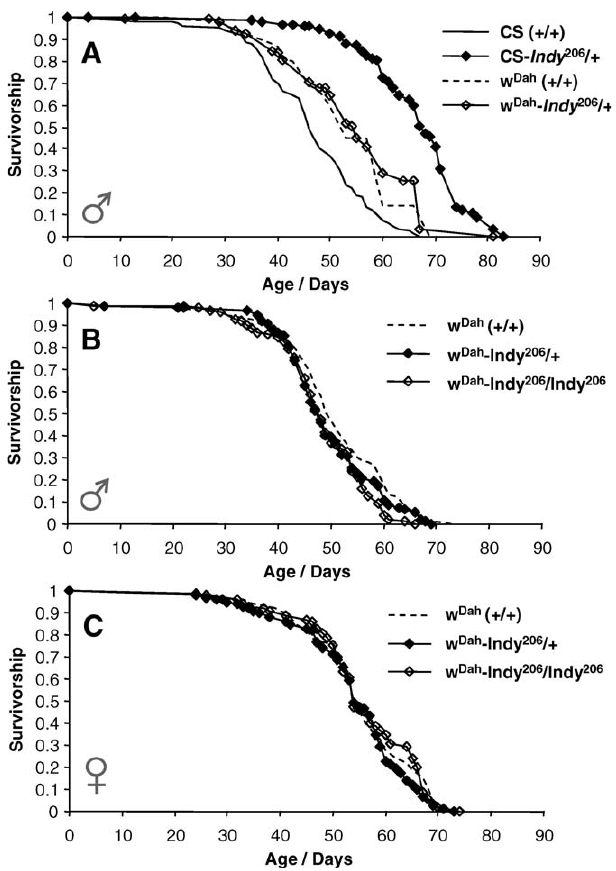
Figure 4. SuccessiveBackcrossingAbolishes Indy 206 -AssociatedLongevity A) Survival of the original versus w Dah -backcrossed ( 3 8) males on SY food. The data are male progeny derived from crosses between Indy 206 (or þ / þ ) homozygote mothers and þ / þ males. Median lifespan is 68 and 46 d for CS- Indy 206 / þ and CS ( þ / þ ) males, respectively (Log rank test v 2 ¼ 131.17, p , 0.0001), and 55 and 53 d for w Dah - Indy 206 / þ and w Dah ( þ / þ ) males, respectively (Log rank test v 2 ¼ 0.06 , p ¼ 0.8009). B) Survival of the w Dah -backcrossed ( 3 10) males on SY food. The flies are all progeny from crosses between w Dah - Indy 206 / þ females and w Dah - Indy 206 / þ males. Median lifespans are 48, 48, and 50 d for homozygous, heterozygous and þ / þ males, respectively. Log-Rank test v 2 and p- values: w Dah - Indy 206 / þ versus w Dah - Indy 206 / Indy 206 ( v 2 ¼ 1.34, p ¼ 0.2467), w Dah - Indy 206 / þ versus þ / þ ( v 2 ¼ 2.08, p ¼ 0.1493), and w Dah - Indy 206 / Indy 206 versus þ / þ ( v 2 ¼ 7.37, p ¼ 0.0066). C) Survival of w Dah -backcrossed ( 3 10) females on SY food. The flies are all progeny from the same crosses as males in Figure 3B. Median lifespans are 54, 54 and 54 d for homozygous, heterozygous and þ / þ females, respectively. Log-Rank test v 2 and p- values: w Dah - Indy 206 / þ versus w Dah - Indy 206 / Indy 206 ( v 2 ¼ 1.37, p ¼ 0.2423), w Dah - Indy 206 / þ versus þ / þ ( v 2 ¼